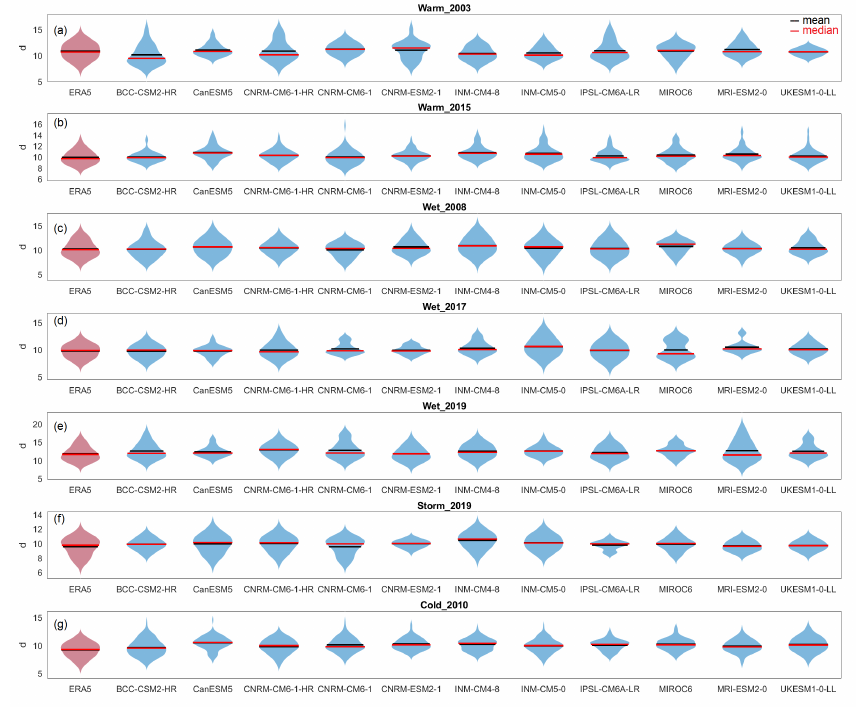
Figure A3. Each row shows violin boxplots of the daily distribution of d for selected extreme events. The red violins are for the ERA5 reanalysis. The other blue violins are for the 11 CMIP6 models. The horizontal black lines represent the mean. The horizontal red lines represent the median.